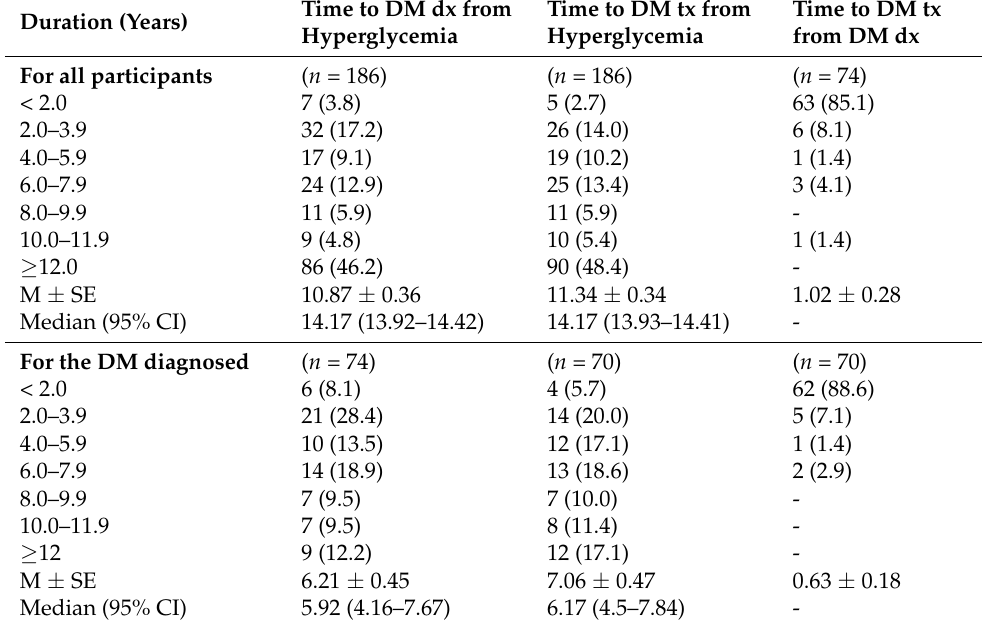
Table 2. Time to DM diagnosis and DM treatment.